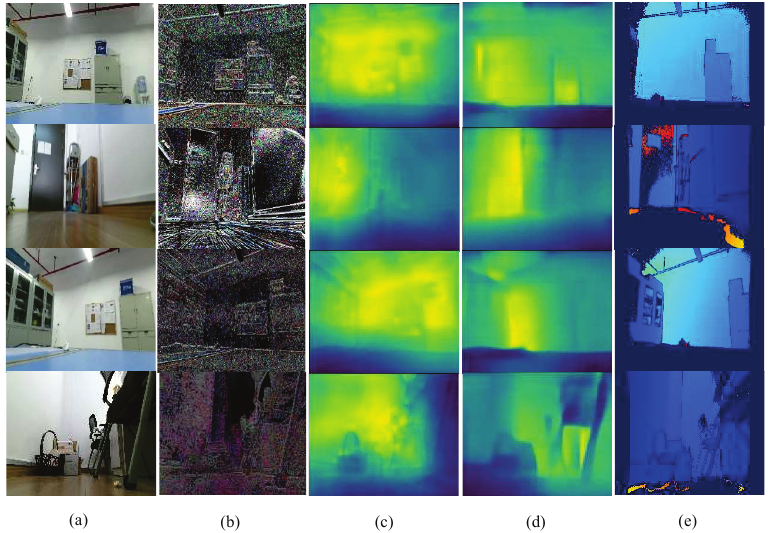
Figure 14. Experimental results of indoor environment depth information inference: ( a ) original scene picture, ( b ) parallax map, ( c ) Laina’s inference result, and ( d ) this chapter’s inference result ( e ) ground